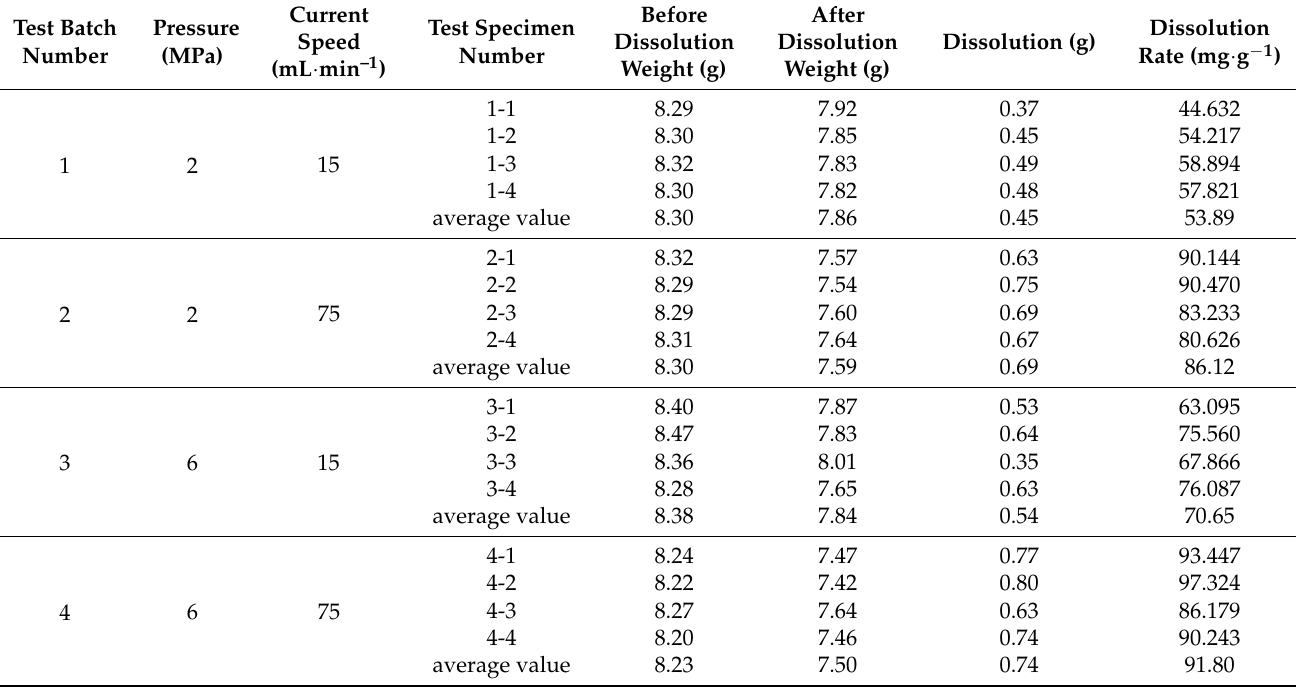
Table 4. The dissolution rate of carbonate rocks under four groups of test conditions.